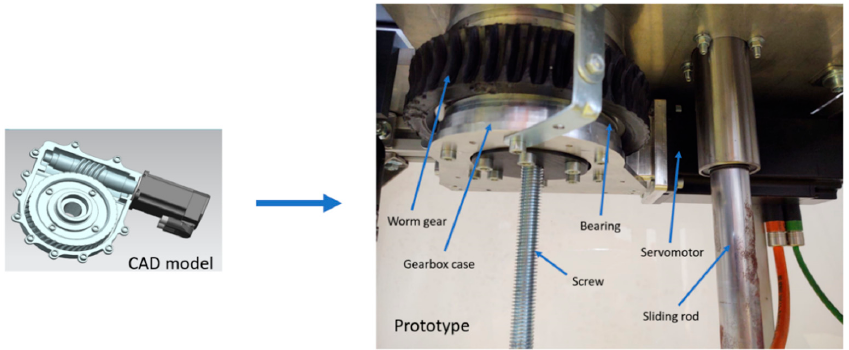
Figure 13. Worm gear (1:45 ratio CAD (Computer Aided Design) model and prototype). Observation 2: Due to the circular guides displacement, sometimes, the flexion–ex- tension mechanism was jammed or slowed down by the patient.